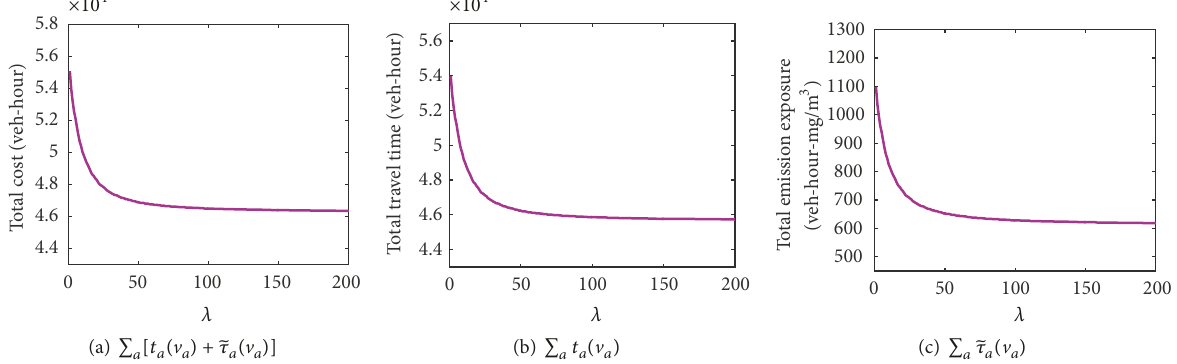
Figure 4: System costs of case 1: (a) total cost; (b) travel time; (c) emission exposure.